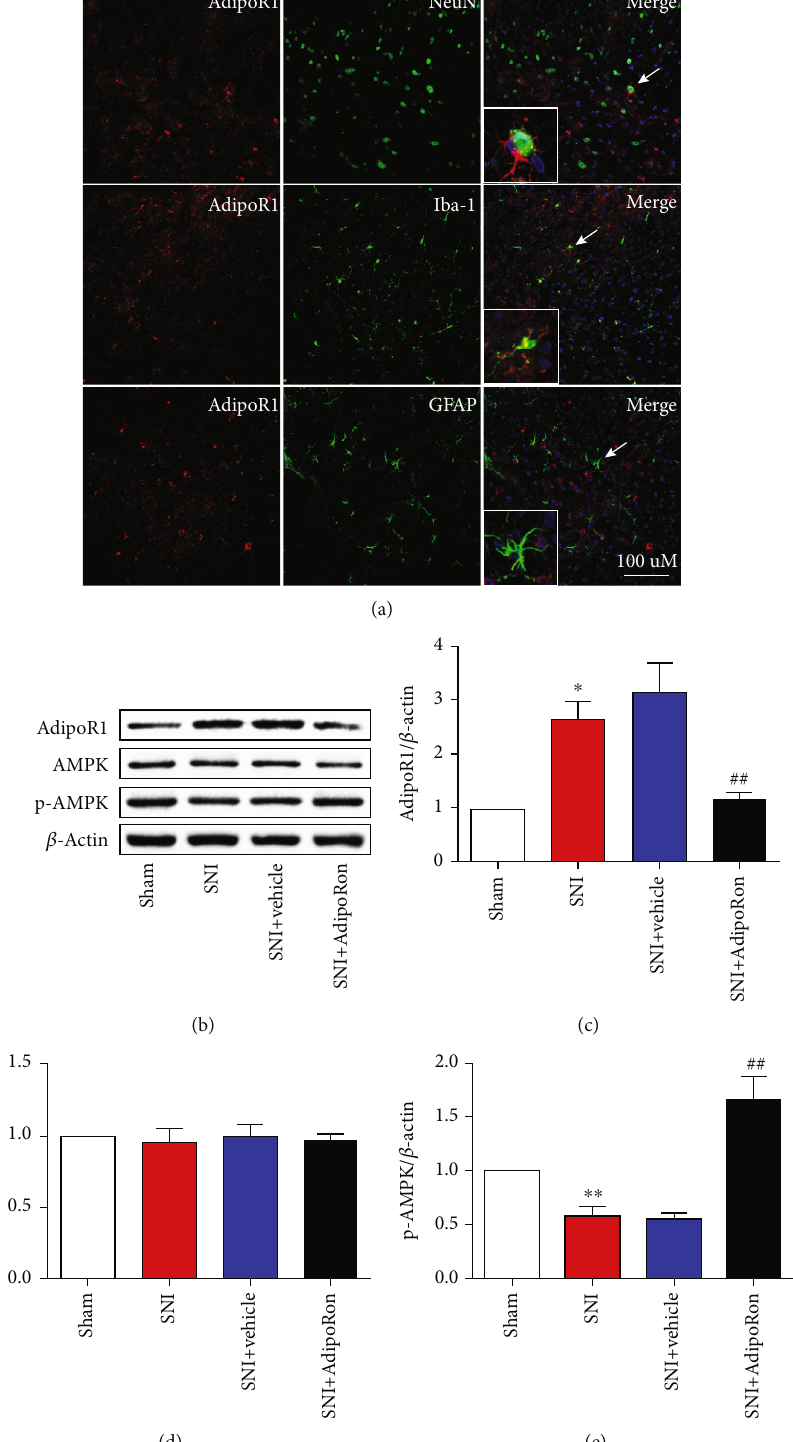
Figure 3: AdipoRon regulated the AdipoR1/AMPK pathway in the ipsilateral spinal cord of SNI mice. (a) Representative fl uorescence images of ipsilateral SDH showing double staining for AdipoR1 (red) and Iba-1 (green), GFAP (green), and NeuN (green), respectively. Scale bar: 100 μ M. (b – e) Representative Western Blots and quanti fi cation of AdipoR1, AMPK, and p-AMPK in the ipsilateral spinal cord of Sham, SNI, SNI+Vehicle, and SNI+AdipoRon on day 7 after surgery. Data were presented as mean ± SEM ( n = 4 per group). ∗ p < 0 : 05 and ∗∗ p < 0 : 01 vs. Sham-Ipsi. ## p < 0 : 01 vs.